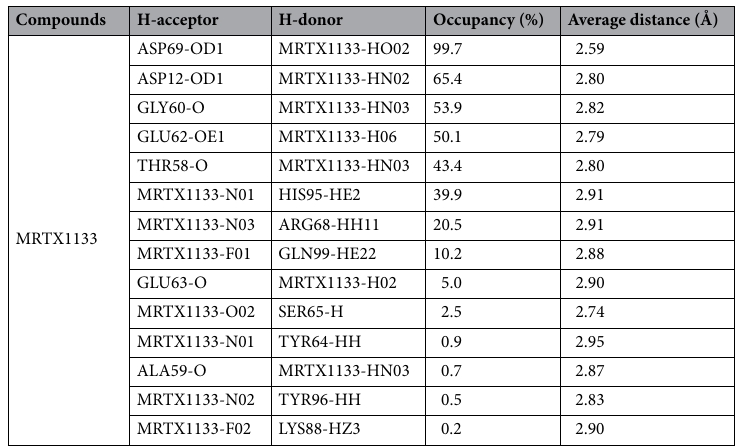
Table 1. Dynamic hydrogen bond interactions of MRTX1133 at KRAS G12D binding site over the 450 ns MD simulation.